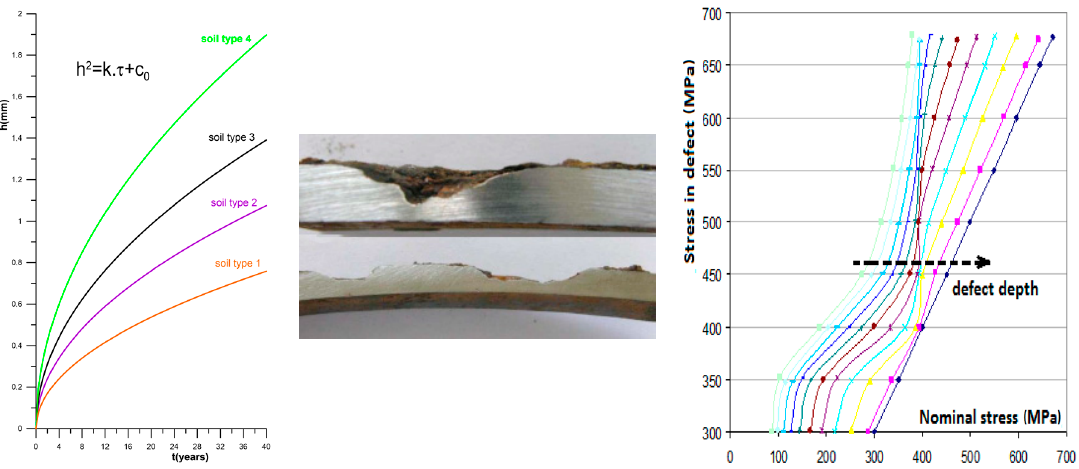
Figure 11. The progress of the corrosion depth over time for different soil types and stress diagram for different depths of corrosion defects for nominal stress values obtained by direct measurements.